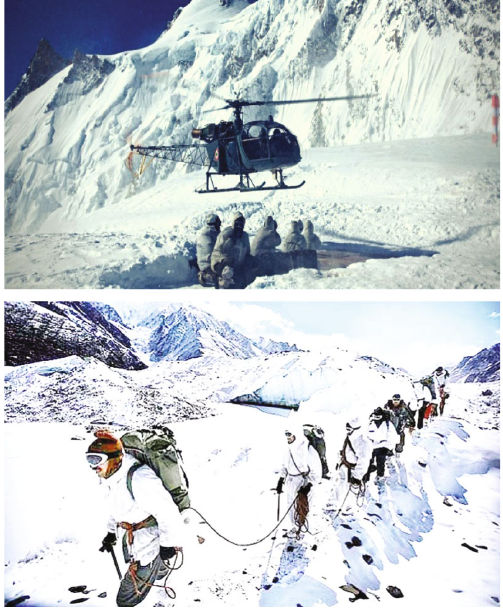
Figure 2: Location of Siachen Glacier [4,